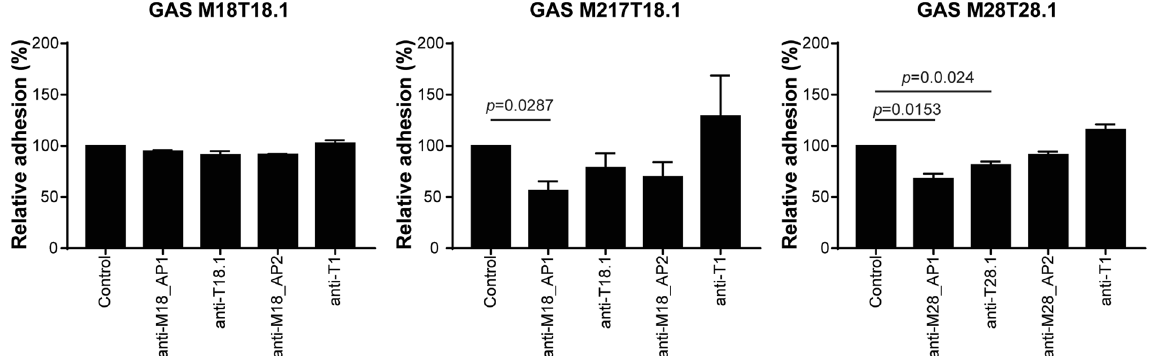
Figure 3. Antibodies against pilus proteins can neutralise adherence of GAS to HaCat cells. HaCat monolayers were incubated with indicated GAS strains for 1 h in absence (control), or presence of purified antibodies. Wells were washed to remove unbound bacteria and amount of bacteria assessed by bioluminescence (which is proportional to CFU). Adhesion was calculated as the proportion of bacteria remaining after washing compared to the unwashed wells. Data is expressed as the percentage of adhesion relative to the no antibody control (which was set to 100%). Bars indicate the mean ± SD of 3 biological replicates. Statistical analysis performed using one-way ANOVA.